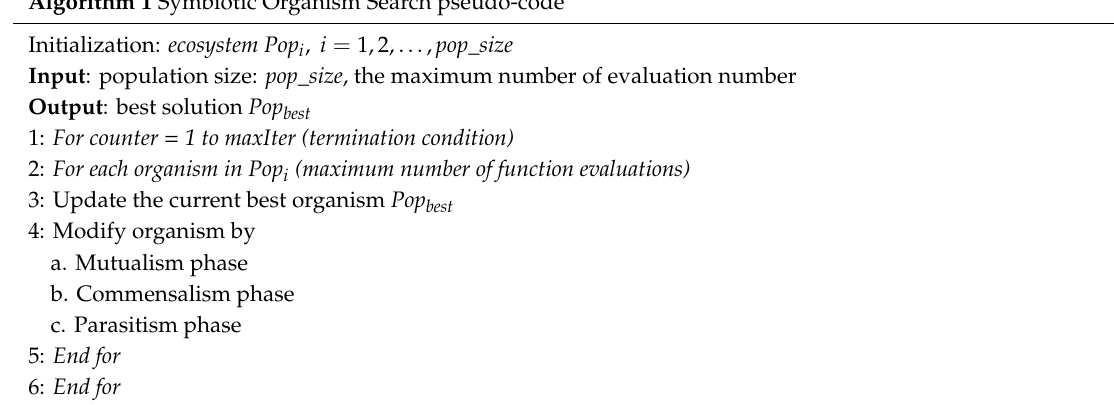
Algorithm 1 Symbiotic Organism Search